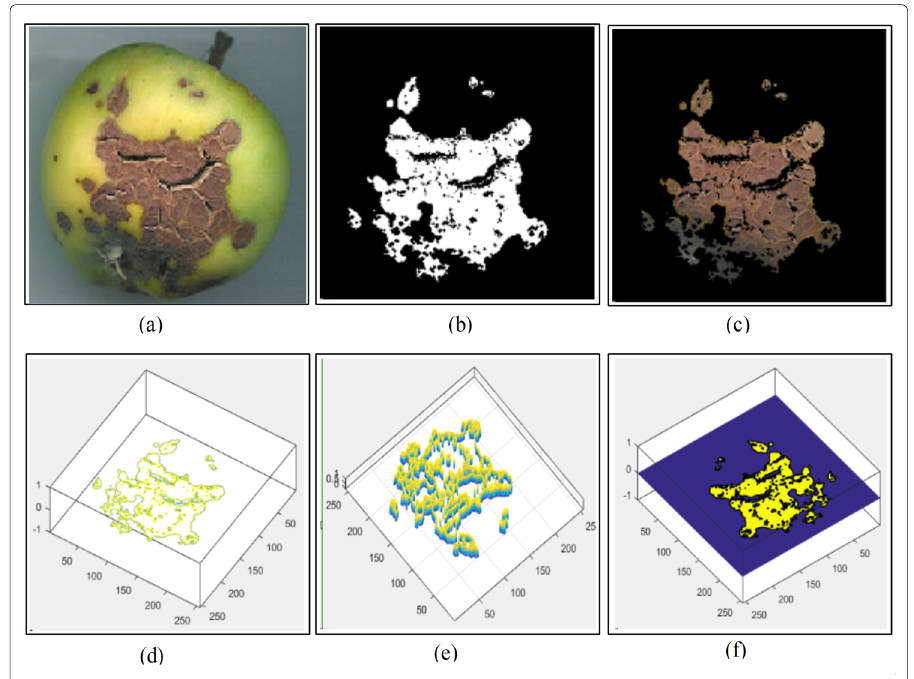
Fig. 7 Proposed fusion results. a Original image. b Segmented image. c Infection part mapped on the original image. d Contour of infection. e 3-D contour image. f Contour image under mesh